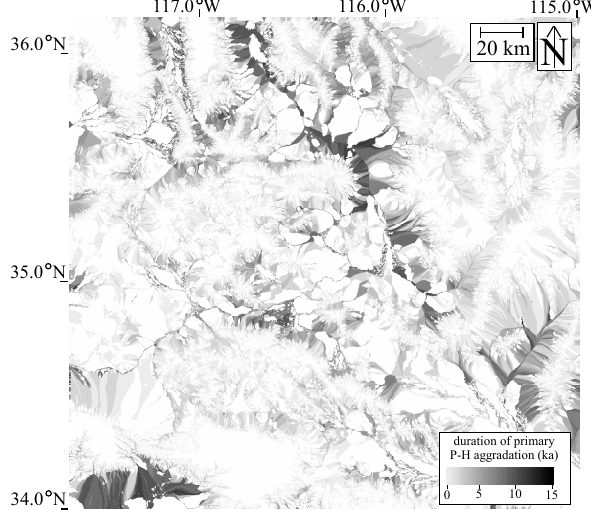
Figure 5. Grayscale map of the duration of primary aggradation associated with vegetation changes of the latest Pleistocene to mid- Holocene in the Mojave Desert (study area is the same as that shown in Fig. 4). Values range from 4–8ka cal at alluvial sites fed by catch- ments with a wide range of elevations in the 750–1800m range (typ- ically lower-elevation sites) to 1–4ka cal at sites fed by catchments with a smaller range of such elevations (typically higher-elevation sites).